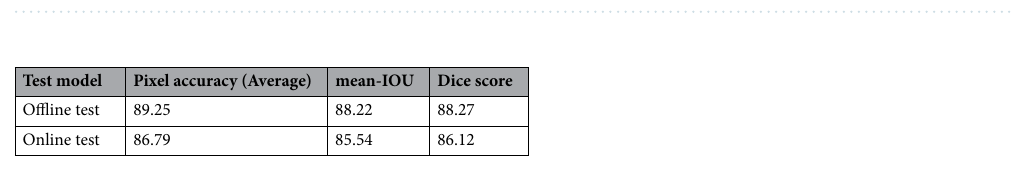
Table 4. Performance analysis for pavement segmentation.